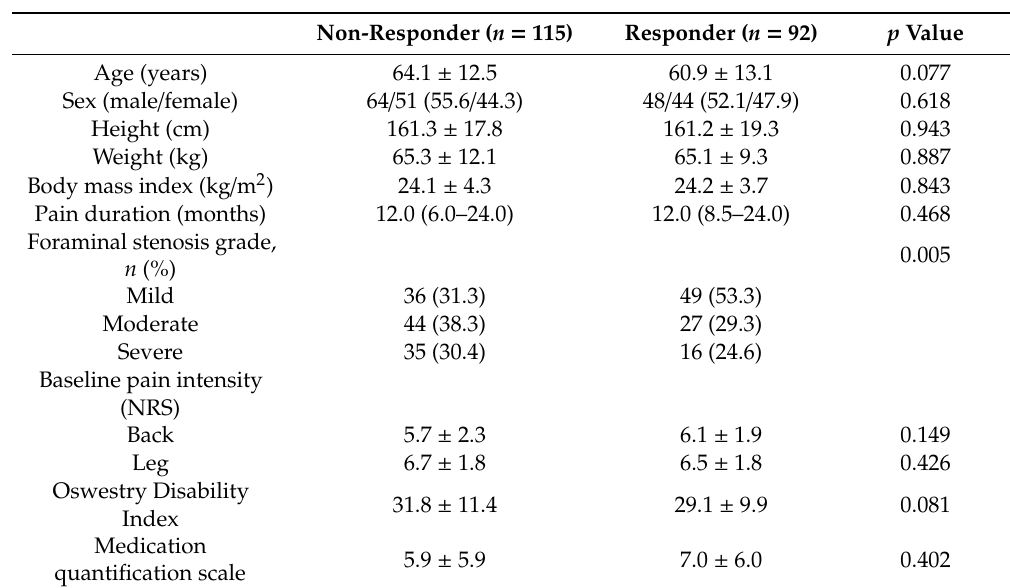
Figure 2. Study flow diagram. Table 1. Patient